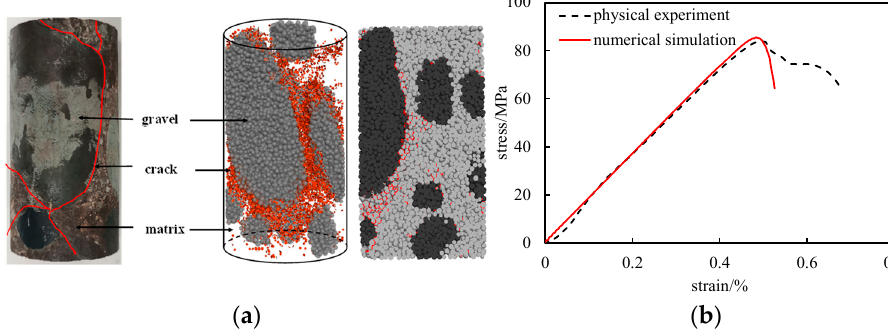
Figure 3. Physical test and numerical model results. ( a ) Failure mode; ( b ) stress–strain curve. Table 1. Meso-parameters .